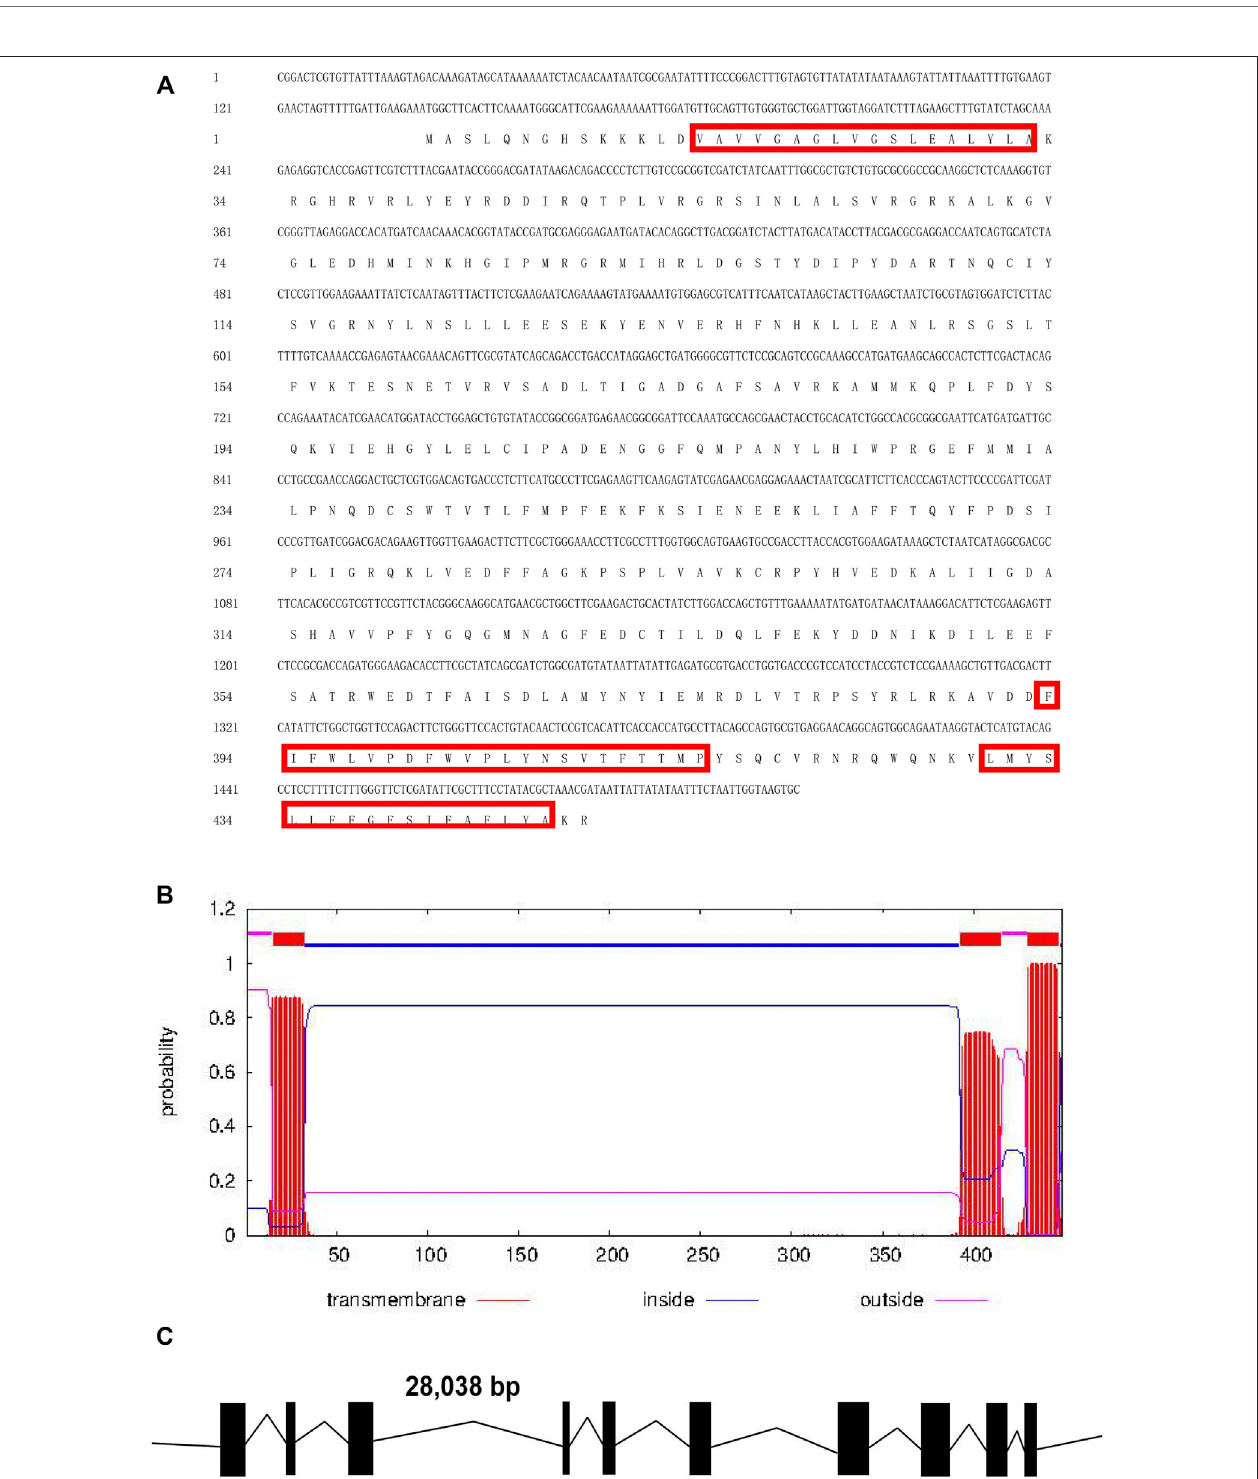
FIGURE 1 | (A) Full-length cDNA sequence of Tuta absoluta cinnabar and its deduced amino acid sequence. Red boxes represented the three transmembrane domains. (B) Predicted conserved domains of the Tacinnabar protein. And three transmembrane domains were found in Tacinnabar. (C) Schematic of the exon/intron structures of the Tacinnabar gene. Solid blocks represented exons, and introns were indicated by full lines. The width of the solid blocks and the length of the black line were drawn in proportion to the actual length of the coding and non-coding regions, respectively.